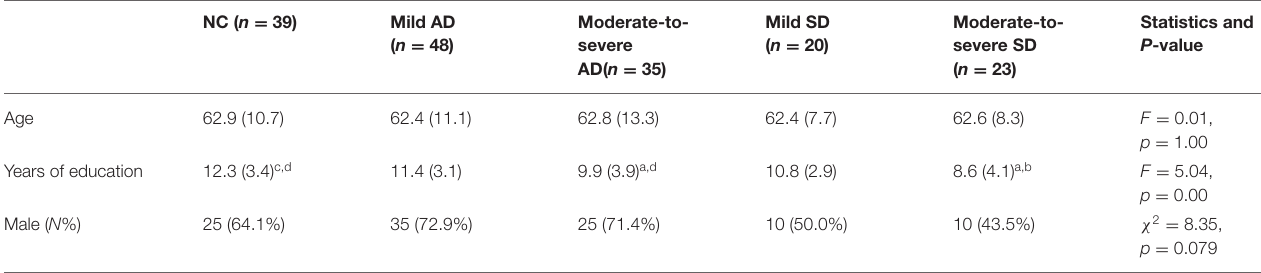
TABLE 1 | Demographic features of the subjects.